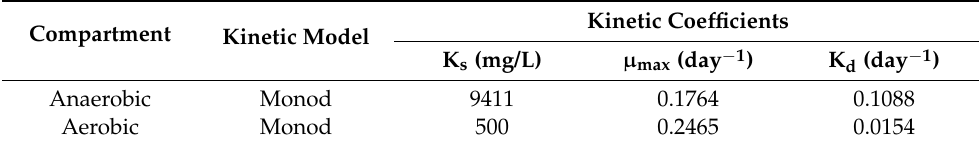
Table A2. Monod kinetic model for anaerobic and aerobic digestion [27]. Compartment